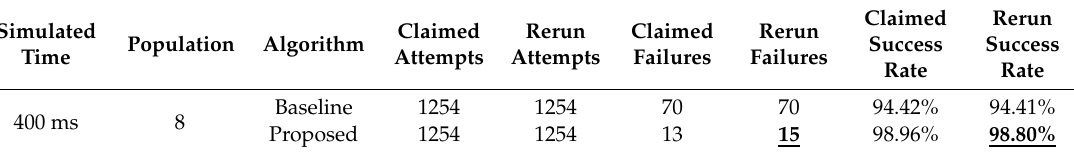
Table 9. Inconsistencies in results.